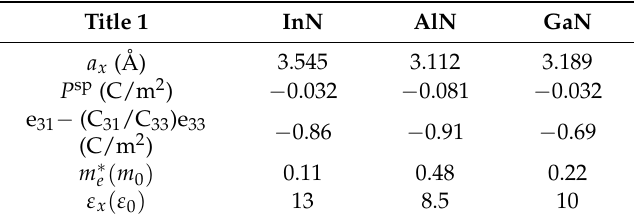
Table 1. Physics parameters of InN, AlN, and GaN at room temperature